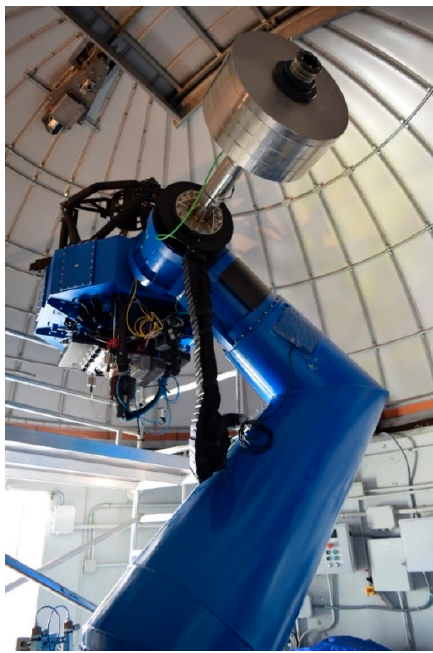
Figure 1. Detail of the T80 telescope.